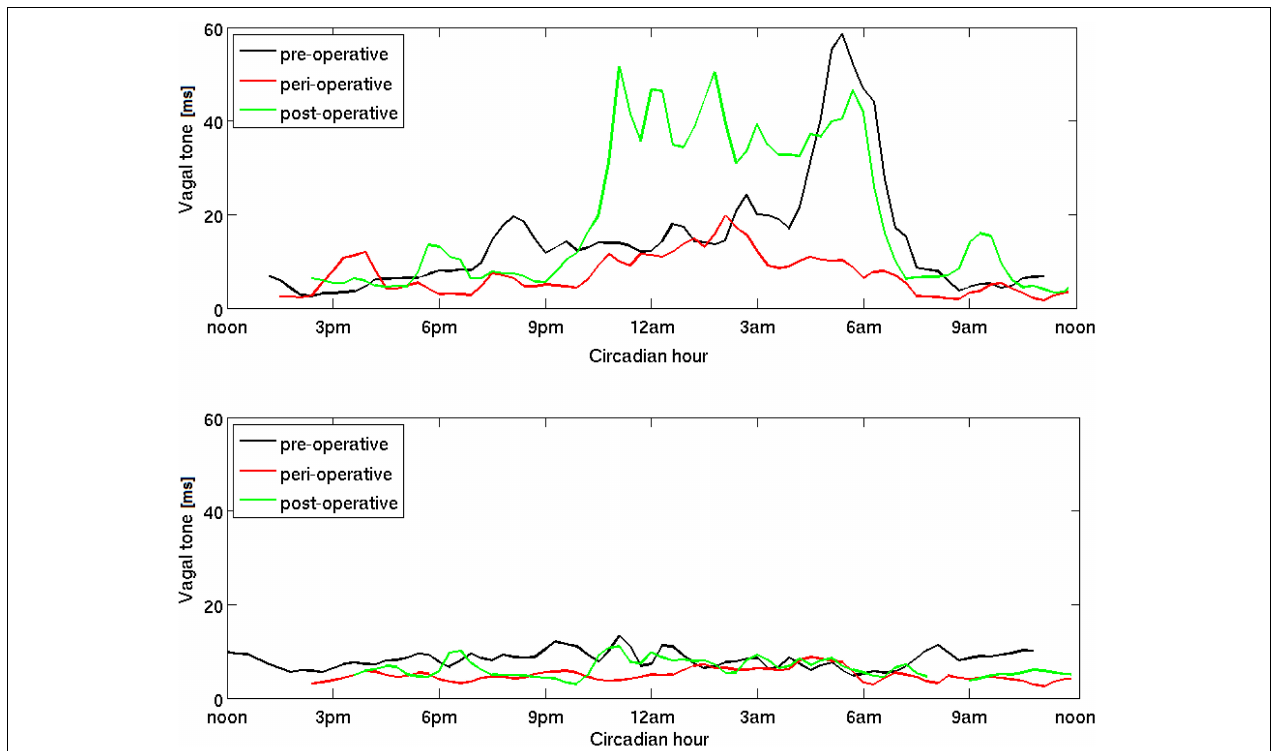
FIGURE 4 | Circadian dynamics of vagal activity (vagal tone) during the operation-rehabilitation process. A patient with a strong pre-operative vagal activity is shown in the top panel and another patient with a weak pre-operative vagal activity is shown in the bottom panel . Three circadian time series for the entire 24 h cycle are shown in each panel, measured on three specific days, pre-operative on T1, peri-operative on T3 and post-operative on T5. We remove the logarithmic scale for better clarity (see section “Materials and Methods”) and use the moving average over a window of several minutes to avoid minute-to-minute fluctuation. While the patient in the top panel shows a clear improvement of post-operative vagal activity, especially during the night, the patient in the bottom panel shows very little improvement, and even during the